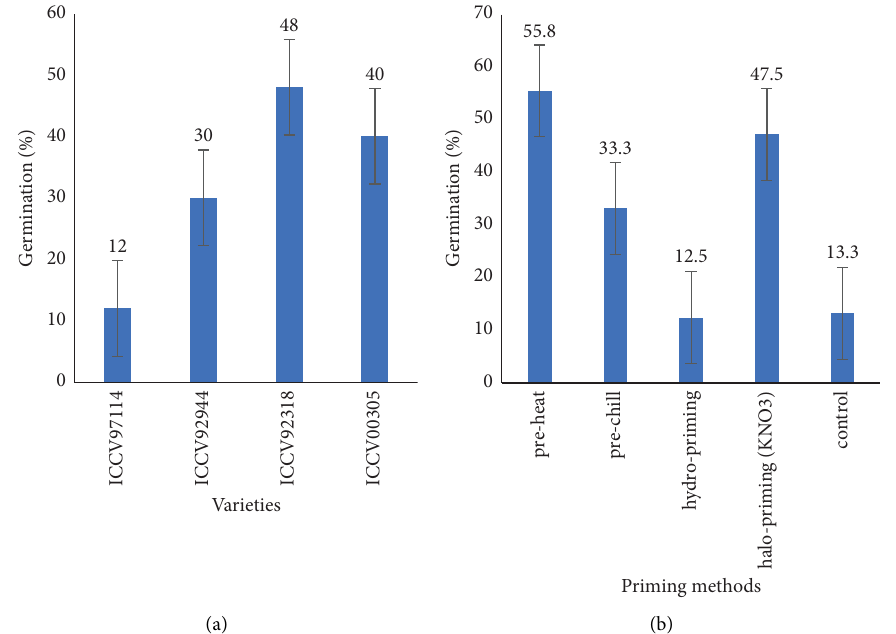
Figure 1: Efect of seed priming and variety on the germination percentage of chickpea. Vertical bars represent standard error bars of